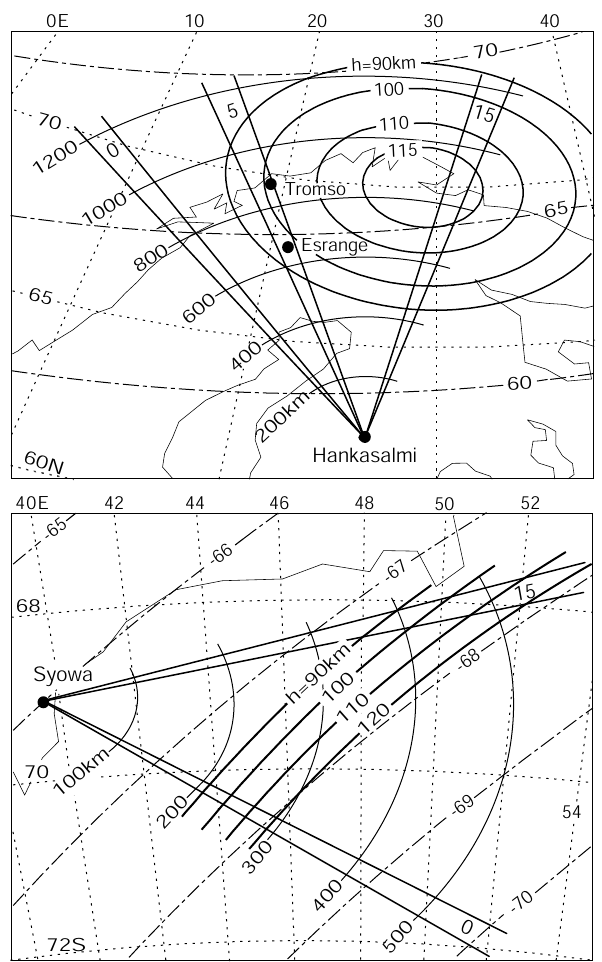
Fig. 1. Fields of view (FOVs) of (top) the Hankasalmi and (bottom) Syowa East HF radars. Each FOV is covered with 16 beams (beam numbers 0, 1, 2, ..., 15). Contour lines of perpendicularity between radar wave vector and the geomagnetic field vector at some altitudes ( h ) are also shown. Ground ranges from the radar site and geo- magnetic latitudes are indicated by the solid and dot-dashed curves,